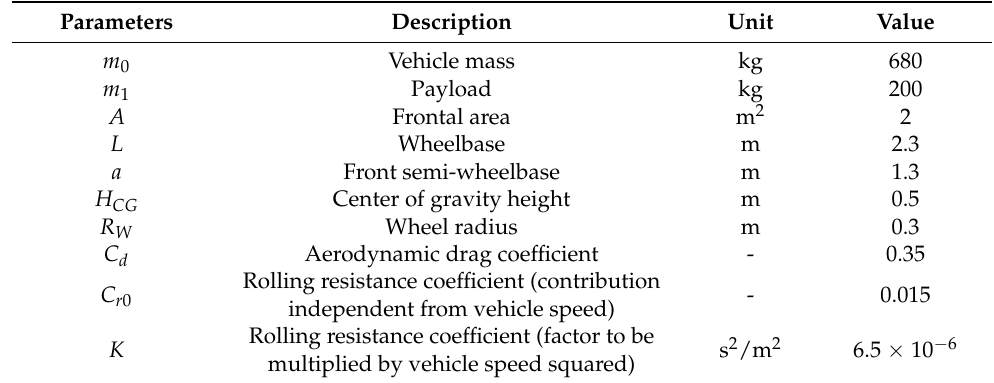
Figure 9. Schematic of the considered EV layout. Table 6. Main EV parameters.